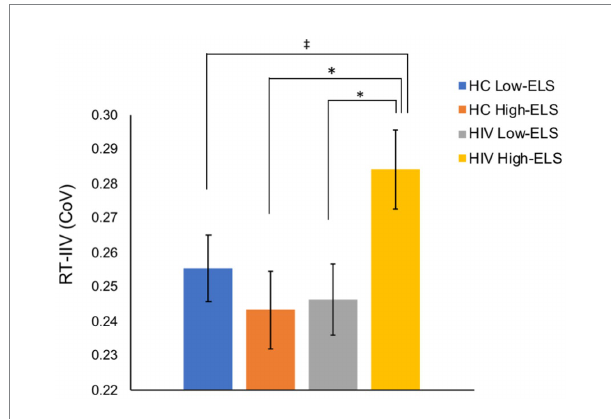
FIGURE 2 The HIV High-ELS group exhibited greater RT-IIV than all other groups. Mean (± standard error of the mean) CoV for each group are displayed. HC, HIV-negative control; ELS, early-life stress; RT-IIV, reaction time intra-individual variability; CoV, coefficient of variation, a measure of variability where higher values indicate greater variability. ( * p < 0.05, ‡ p <